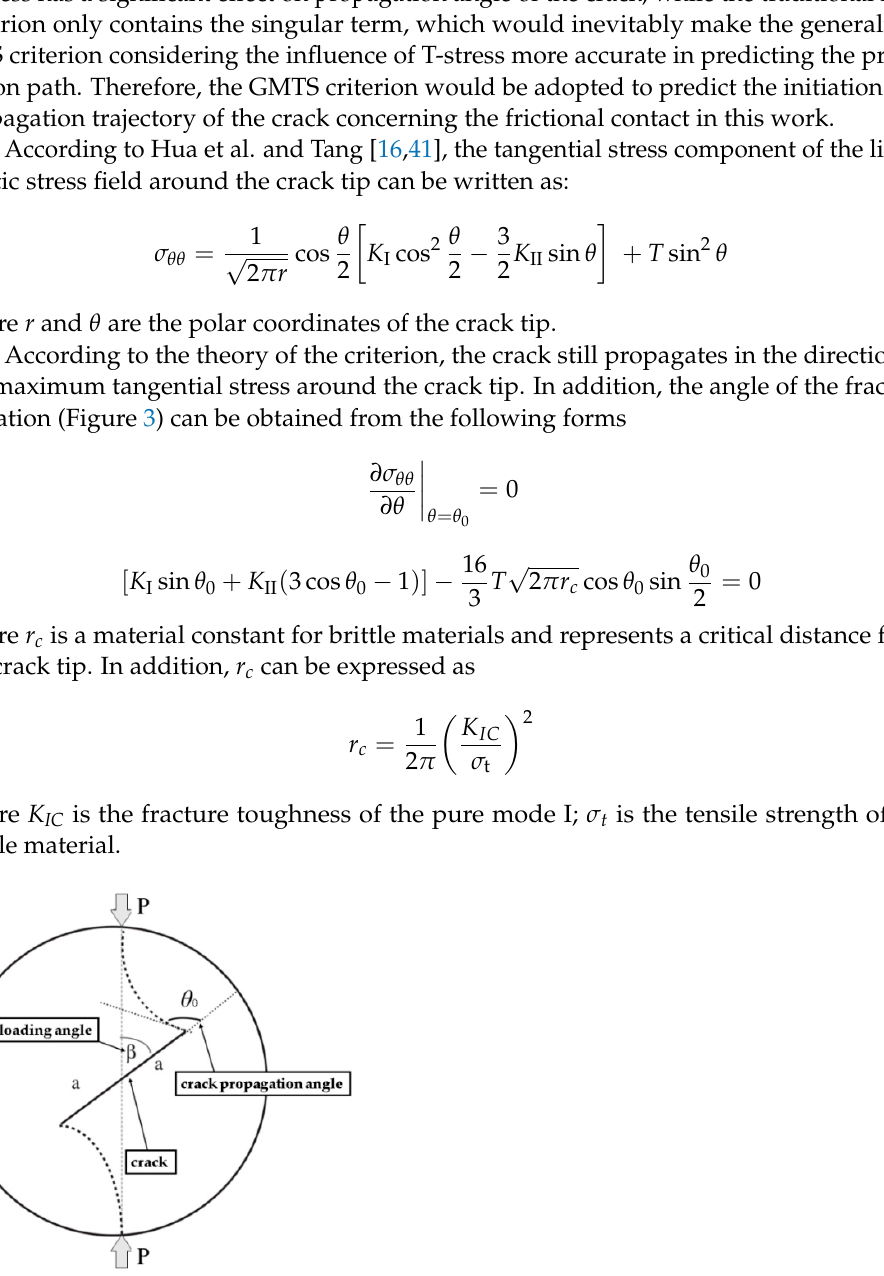
Figure 3. Schematic of the crack propagation angle and loading angle.